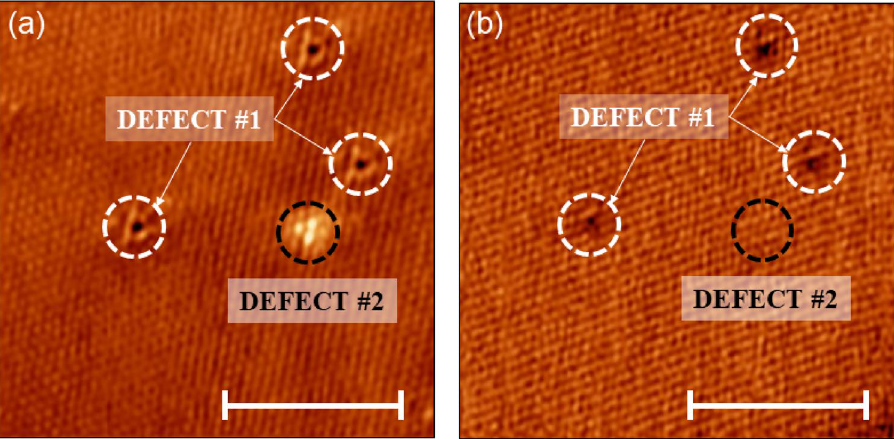
Figure 1. Energy dependent STM on defects. ( a ) and ( b ) show the STM topography of the same area of monolayer MoS 2 measured at − 0.7 V and + 0.7 V, respectively (I = 110 pA and 130 pA, respectively). Two types of defects are displayed: defect #1 outlined with a white circle and defect #2 outlined in a black circle. All scale bars represent 5